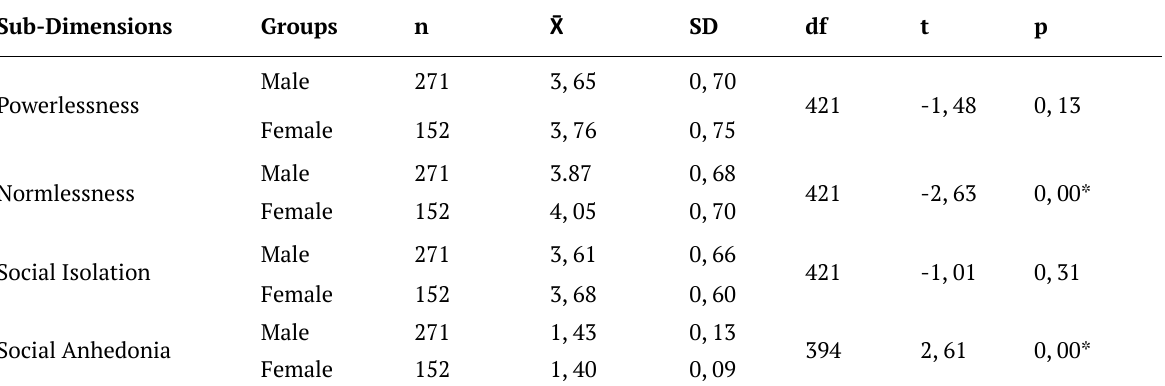
p<0.05. Table 4. The differences between the sub-dimensions of RSAS and DAS according to the athlete status of the students